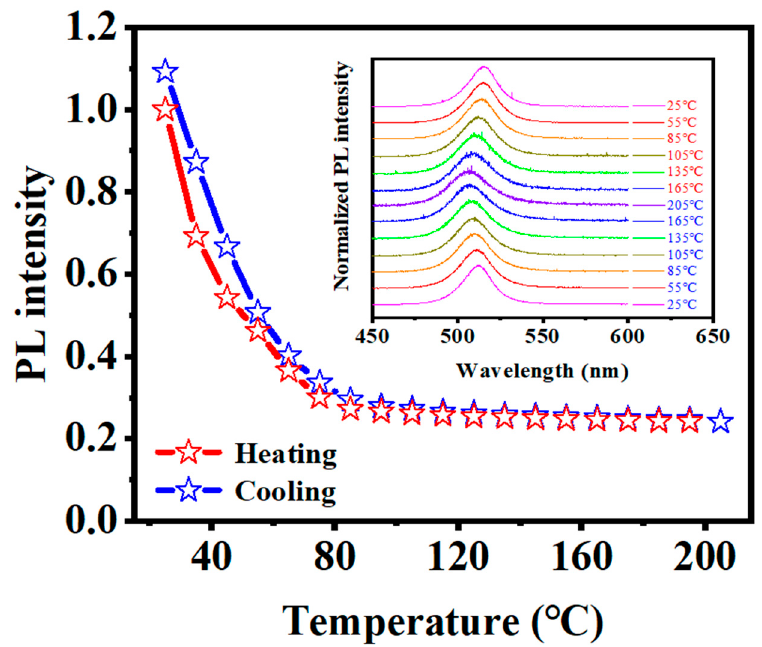
Figure 7. Heating and cooling cycling measurements of the CsPbBr 3 QDs encapsulated by the layers with SiC x N y phase at various temperatures. The inset presents the PL spectra vs.